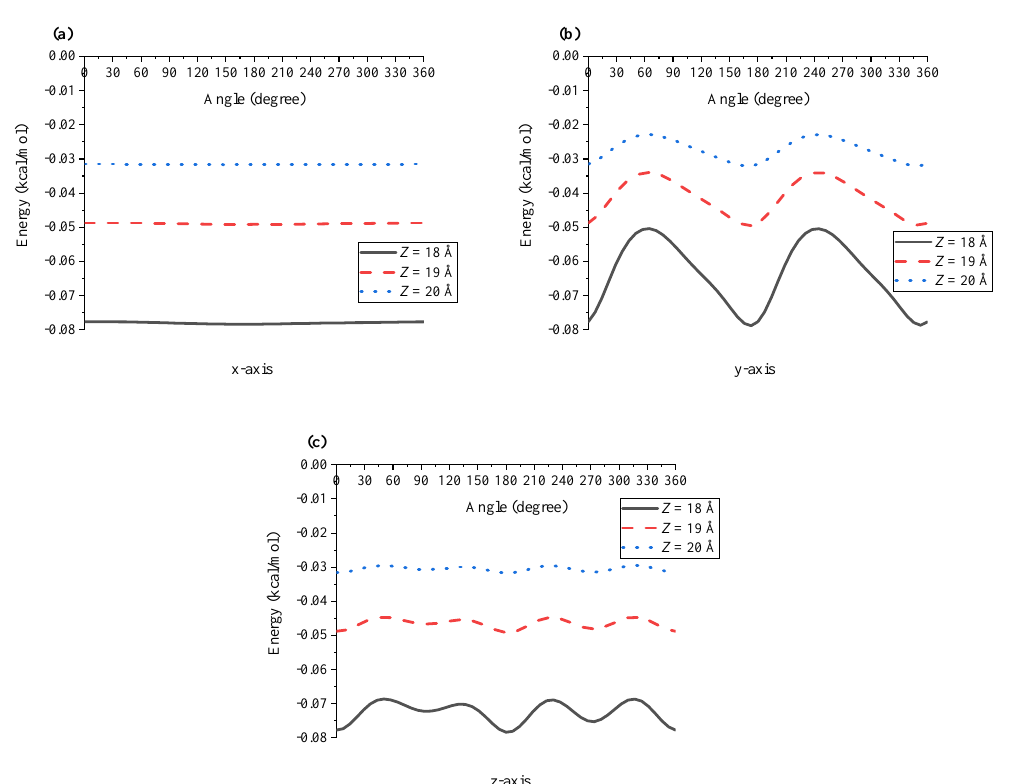
Figure 3. Interaction energy between two dye molecules when first molecule rotates about ( a ) x -, ( b ) y -, and ( c ) z -axis.